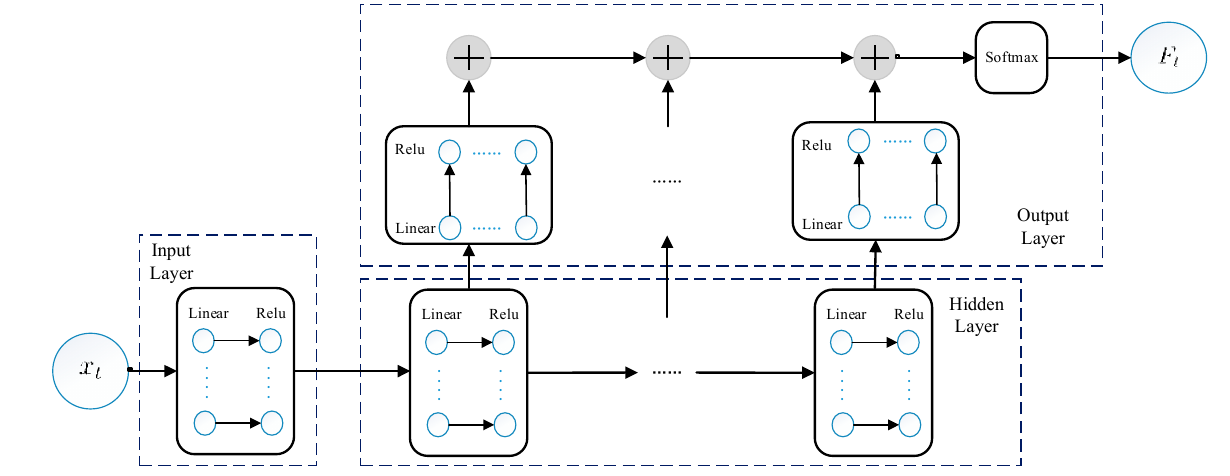
Figure 4. The network of the online safety classifier based on residual learning. The online safety classifier’s network structure is similar to LSTM (long short-term memory) and an output layer is added to each hidden layer, then the results of all output layers are added. LSTM has been successfully applied to power consumption forecasting [39] and energy saving [40]. The main structure of LSTM is shown in Figure 5.